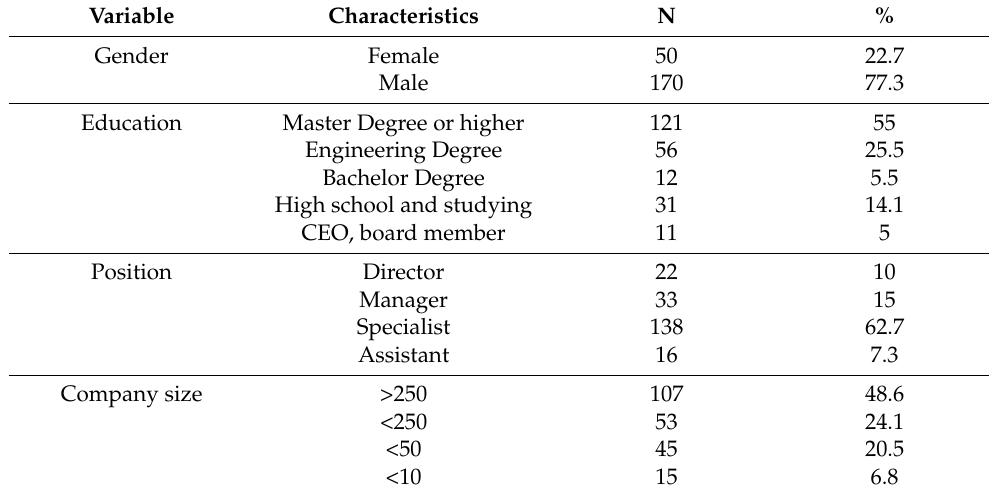
Table 5. Demographic profile of respondents.